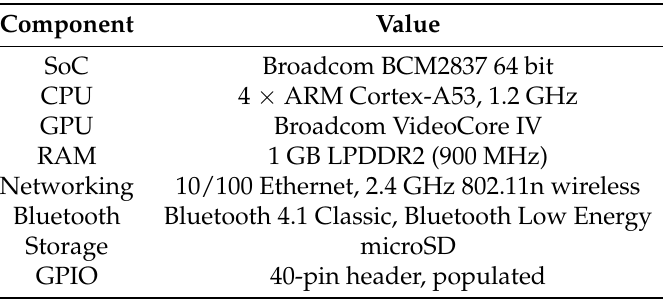
Table 2. Raspberry Pi 3